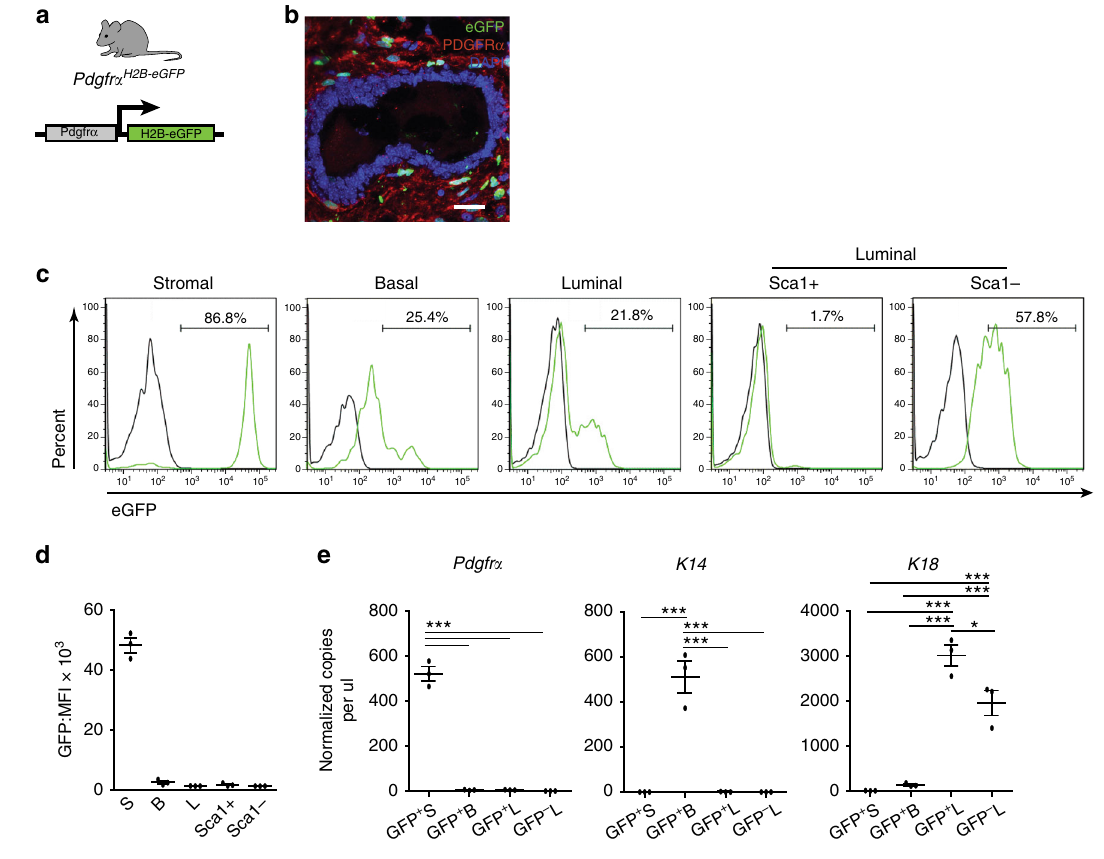
Fig. 3 Endogenous Pdgfr α promoter activity in the mammary gland. a A mouse reporter for endogenous Pdgfr α promoter activity. b Co-staining for H2B- eGFP and PDGFR α in the adult gland (representative of n = 3 mice and 5 fi elds per tissue section); scale bar = 25 µ m. c Flow cytometry histograms depicting H2B-eGFP + cells (green) in mammary subsets relative to wild-type control (black). d Mean fl uorescence intensity (MFI) of H2B-eGFP in ( c ) ( n = 3 mice). e Droplet digital PCR analysis of Pdgfr α , K14 , K18 normalized to Gapdh in FACS-sorted GFP + and GFP - cell fractions from reporter mice (isolated from n = 3 individual mice). Data represent mean± s.e.m. * p < 0.05, *** p <0.001 (one-way ANOVA). Source data are provided as a Source Data fi